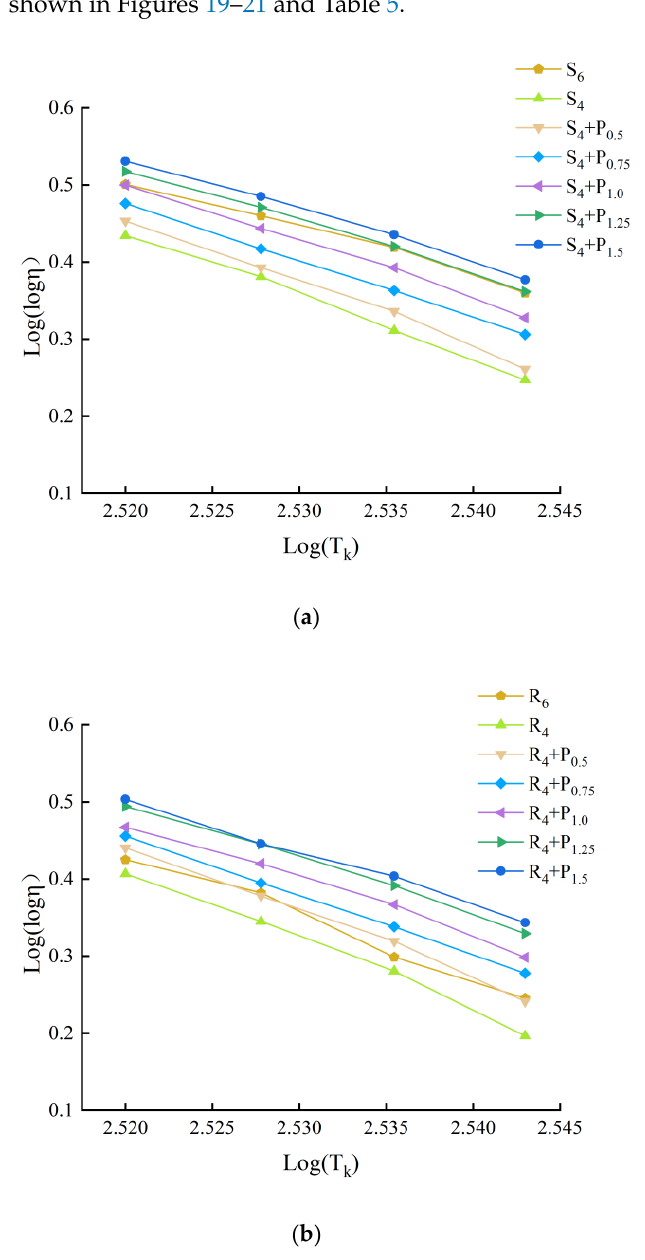
Figure 19. Double logarithm regression viscosity temperature curve of DH–70# asphalt: ( a ) PPA–SBS compound ratio; ( b ) PPA–SBR compound